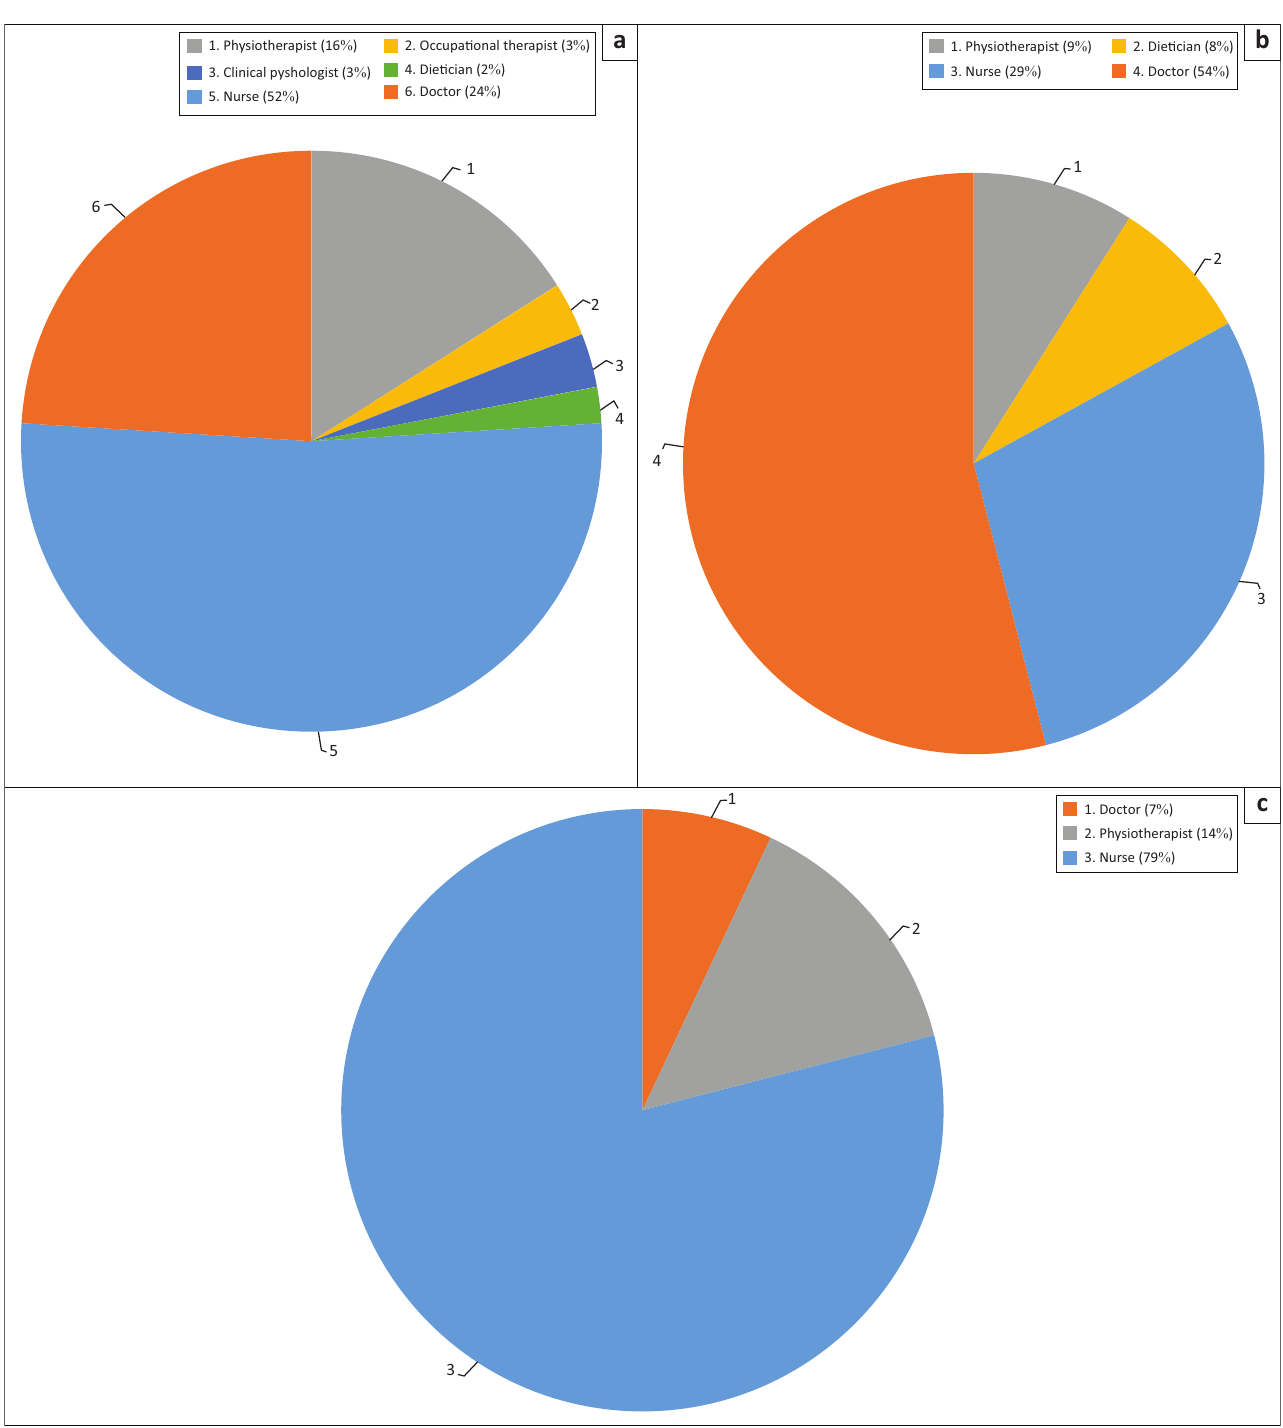
FIGURE 1: Distribution of healthcare professionals at the tertiary, secondary and primary level